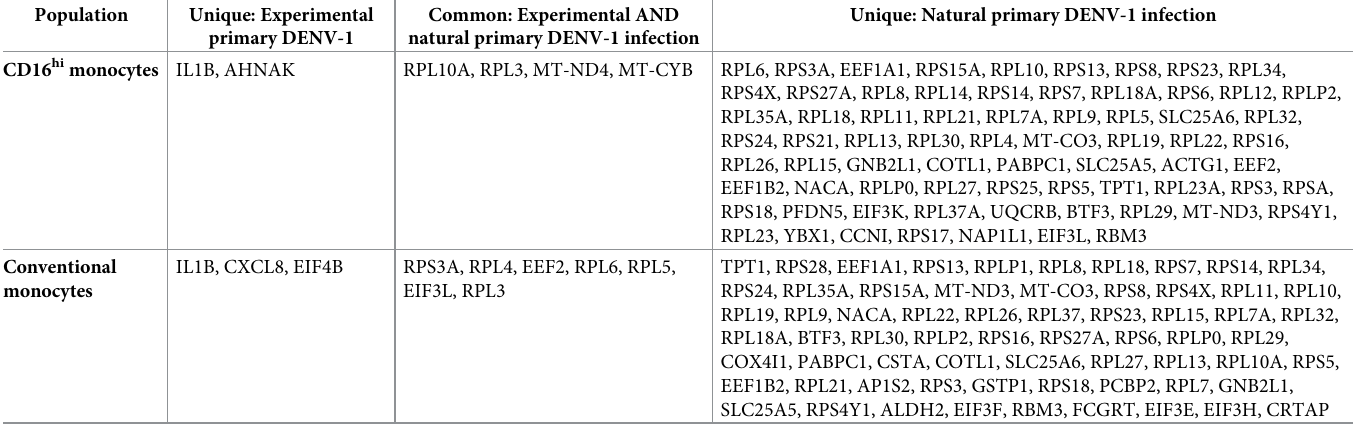
Table 3. Conserved and unique infection-suppressed cDEG identified following natural primary DENV-1 infection or experimental primary DENV-1 infection on study day 10.